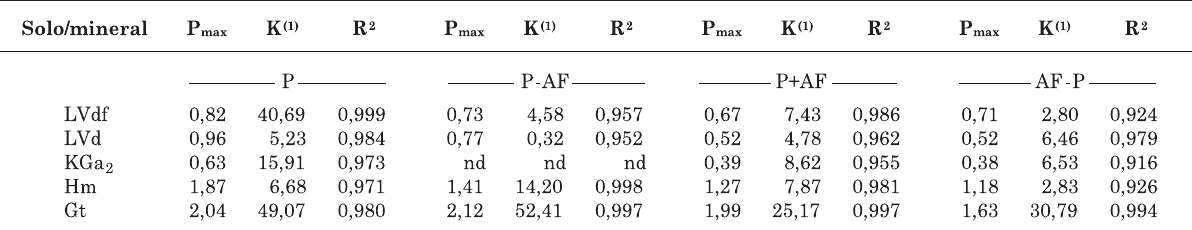
fúlvicoQuadro 2. Coeficientes das isotermas de adsorção de P (X em μ mol m -2 P) e coeficiente K (mL m -2 ) nas max frações argila do LVdf, LVd, KGa natural e Hm e Gt sintéticas para a região de baixas concentrações 2